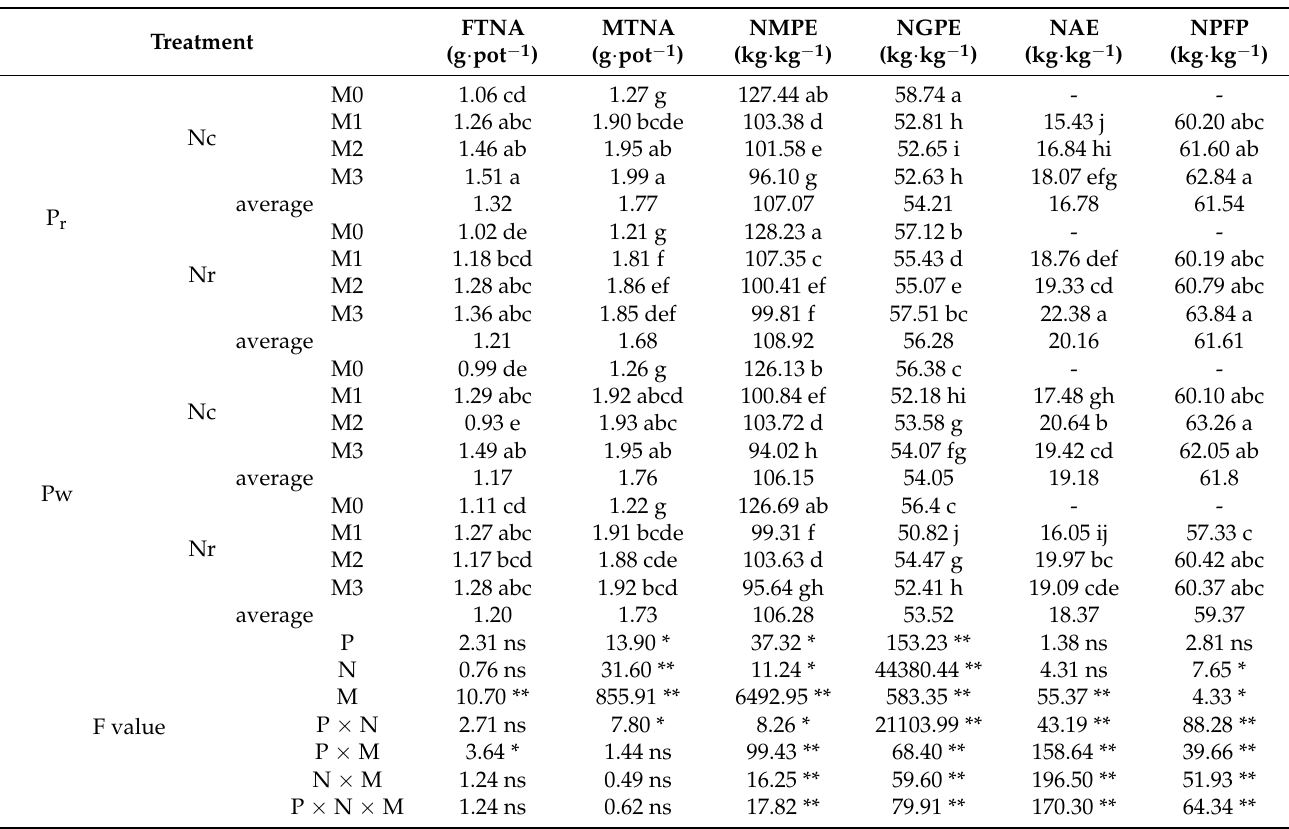
Table 5. Effects of N application in the previous season and N management in rice season, on N accumulation and N use efficiency (NUE) in